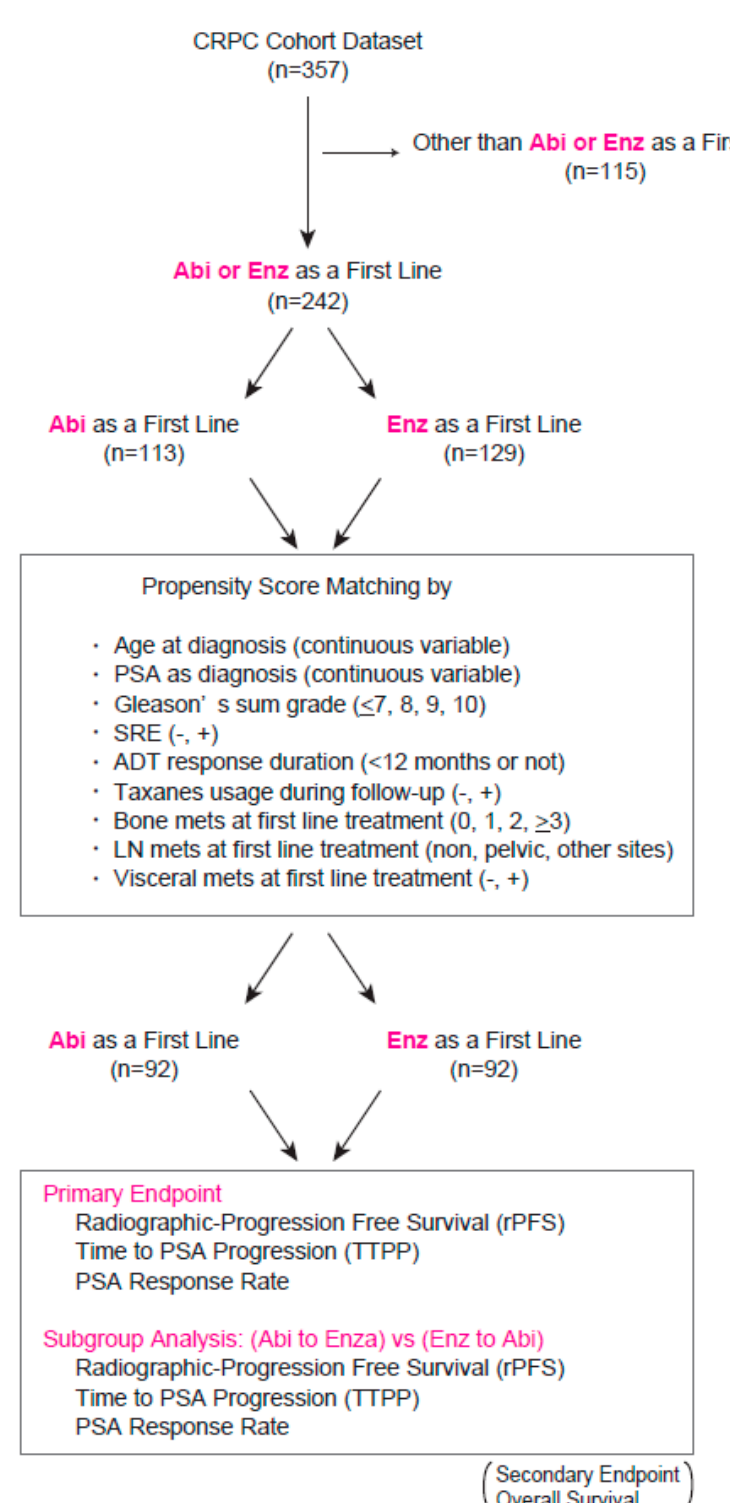
Figure 1. Study design and inclusion criteria of the propensity score-matched analysis in patients newly diagnosed with castration-resistant prostate cancer (CRPC). A 1:1 matching across the two treatment arms was performed using the nearest neighbor method with a 0.2-width caliper of the standard deviation of the logit of the propensity